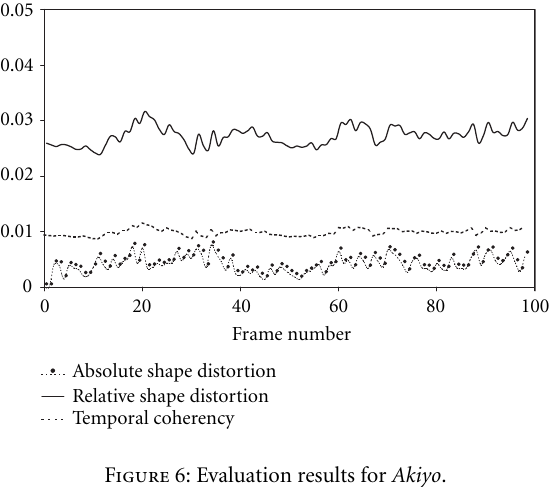
Figure 6: Evaluation results for Akiyo .